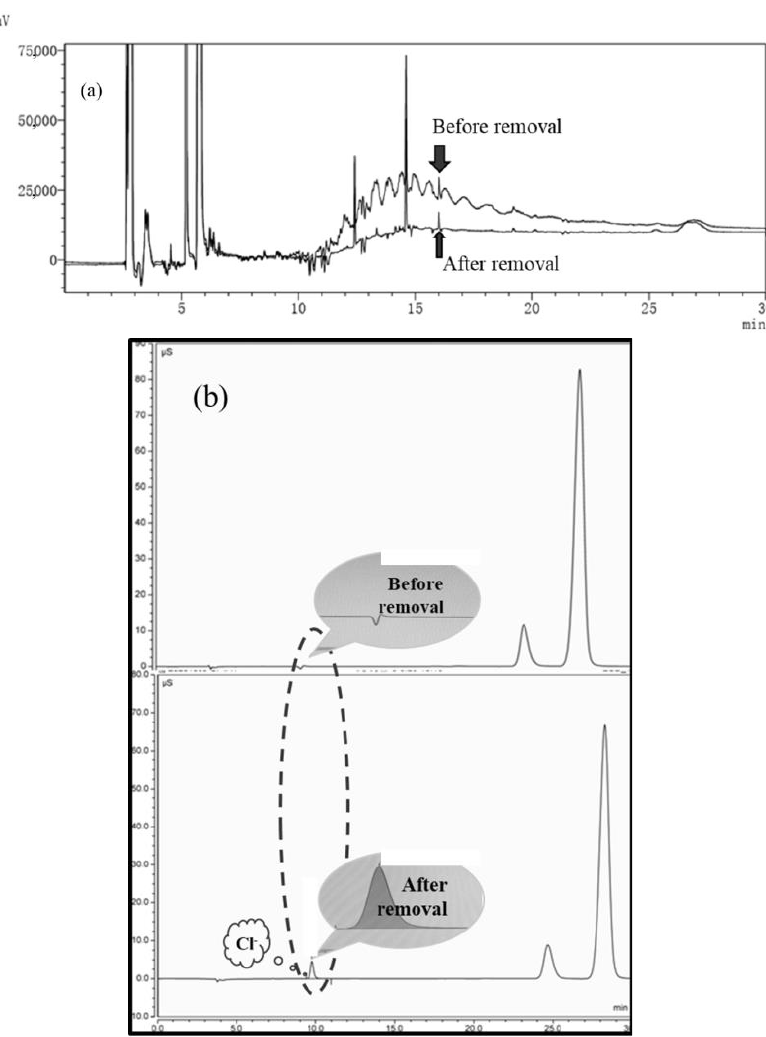
Figure 7. E. coli strain 2 degradation of SCCPs: ( a ) changes in the SCCPs; ( b ) changes in the concentration of chloride ions in solution. SCCPs, short-chain chlorinated paraffins.